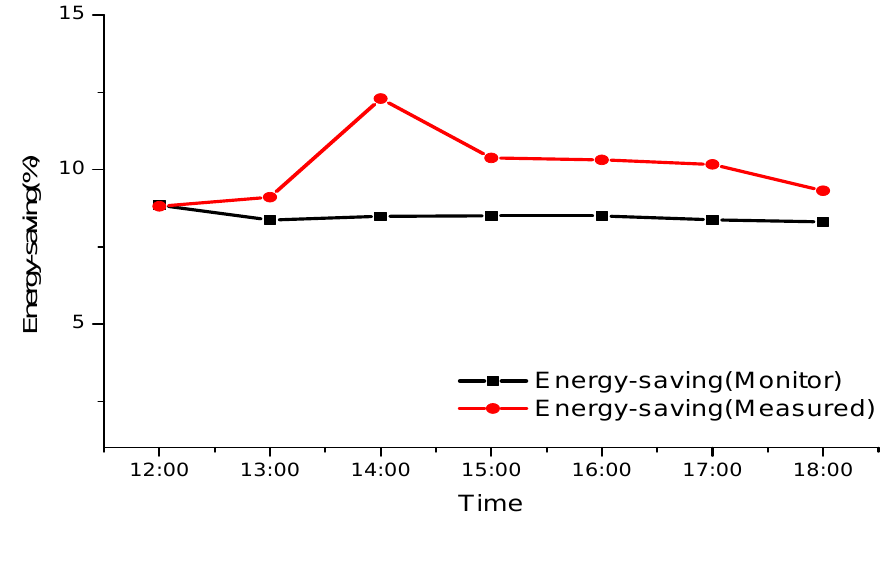
Figure 10. Comparison with real measured